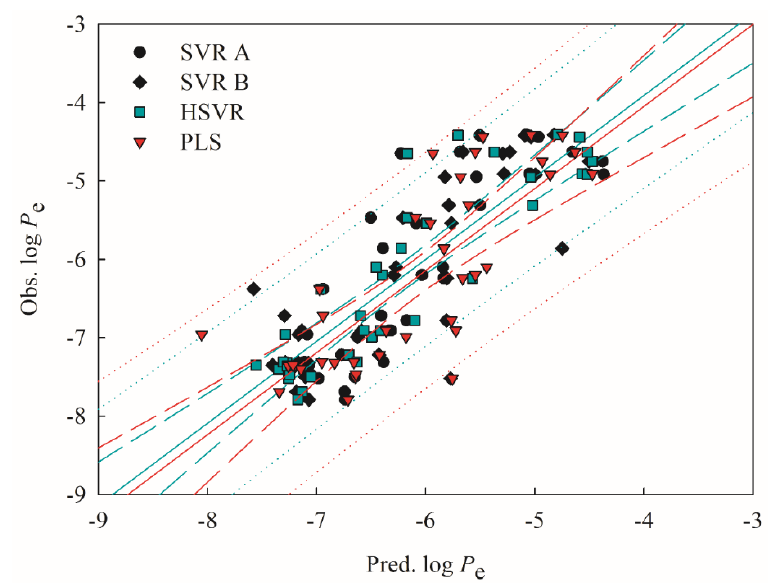
Figure 4. Observed log P e vs. the log P e predicted by SVR A (solid circle), SVR B (solid diamond), HSVR (green square), and PLS (red triangle) for the molecules in the test set. The green and red solid lines, dashed lines, and dotted lines correspond to the HSVR and PLS regressions of the data, 95% confidence intervals for the HSVR and PLS regressions, and 95% confidence intervals for the prediction, respectively.